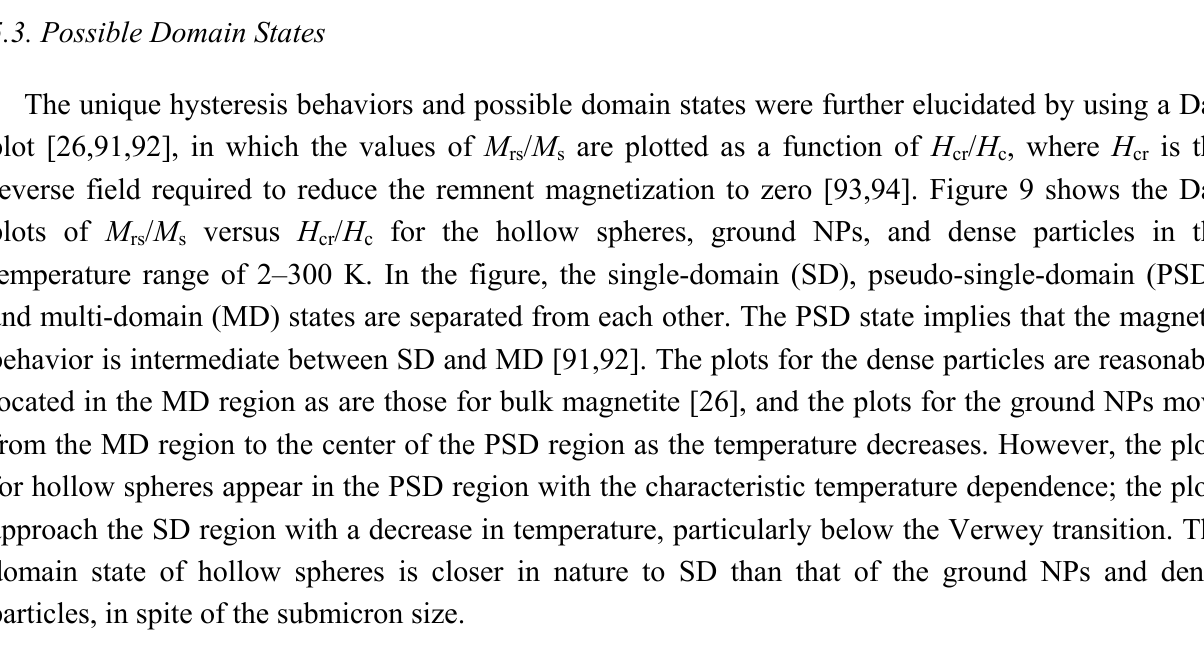
/ M versus H / H for the hollow spheres, dense particles and rs s cr c